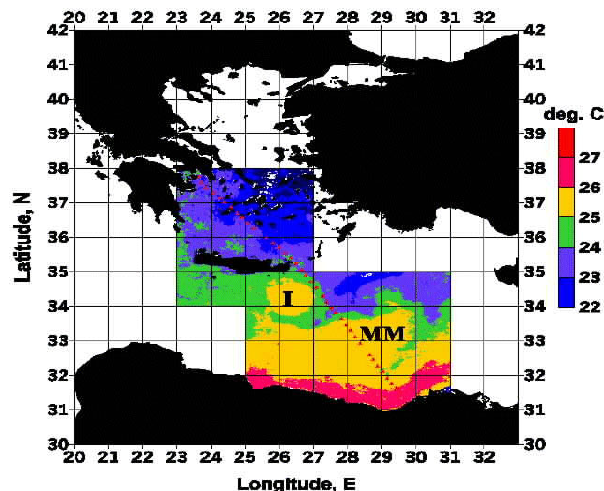
Fig. 2. Sea-surface temperature distribution during the first PI- RALEX transect on 23 October 1999. The Ierapetra and Mersah- Matruh anticyclonic eddies are identified by their initials (I and MM, respectively). The positions of the XBT drops are marked by red